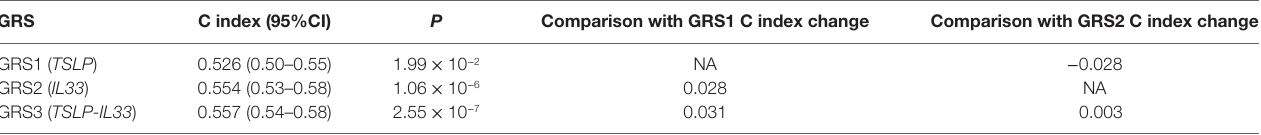
TaBle 5 | Comparison of the GRSs for prediction of CAD in the combined population. comparison with grs1 c index change comparison with grs2 c index change